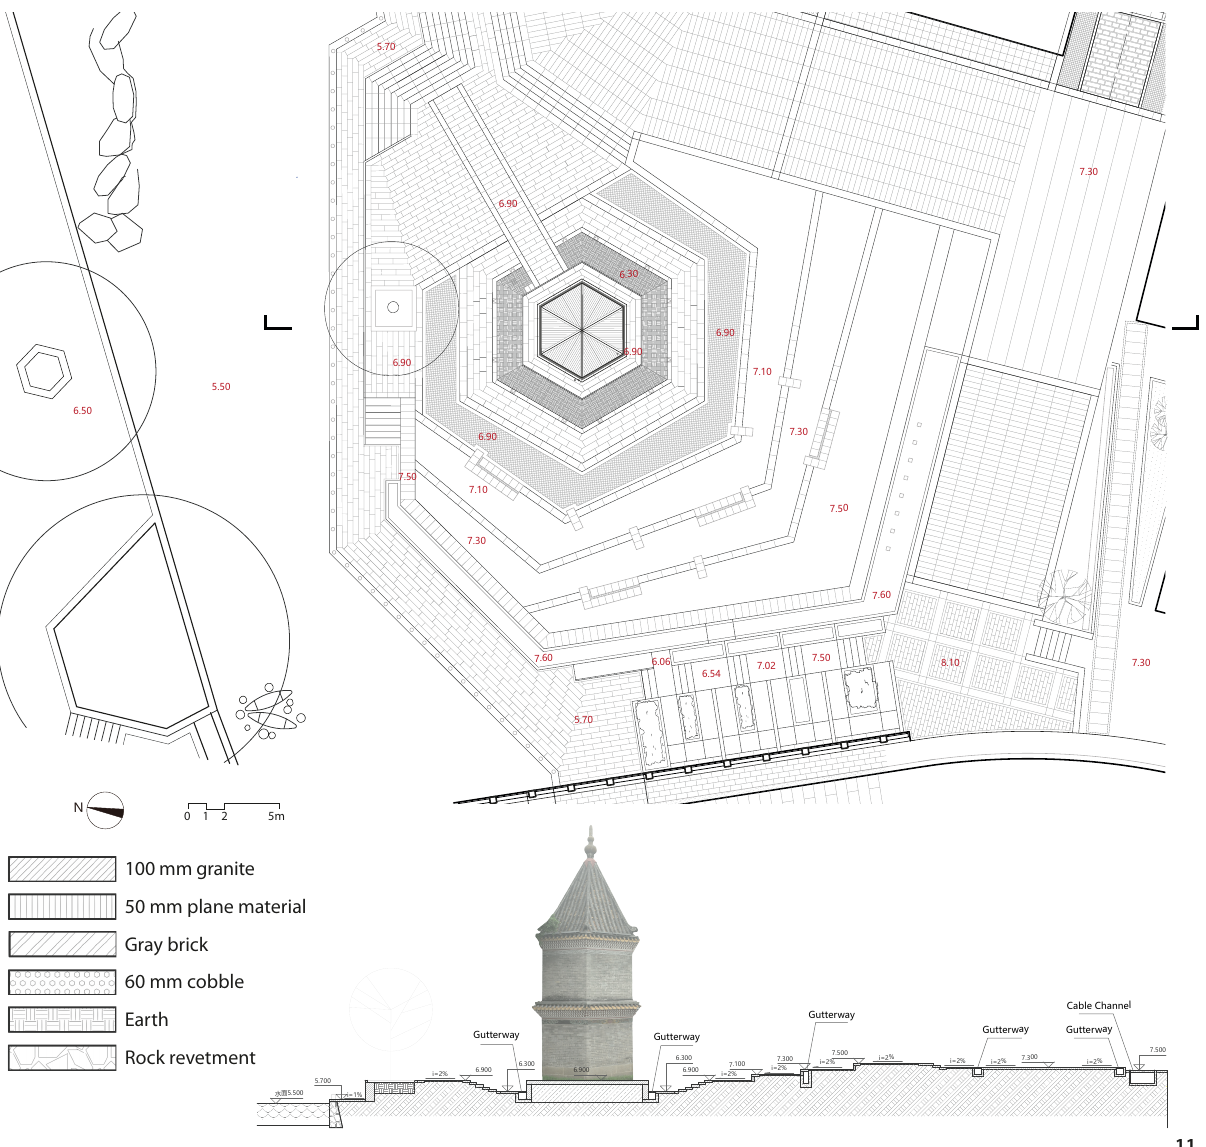
Figure 11 Section design of the Pagoda Plaza (Source: Urban Elephant, South China University of